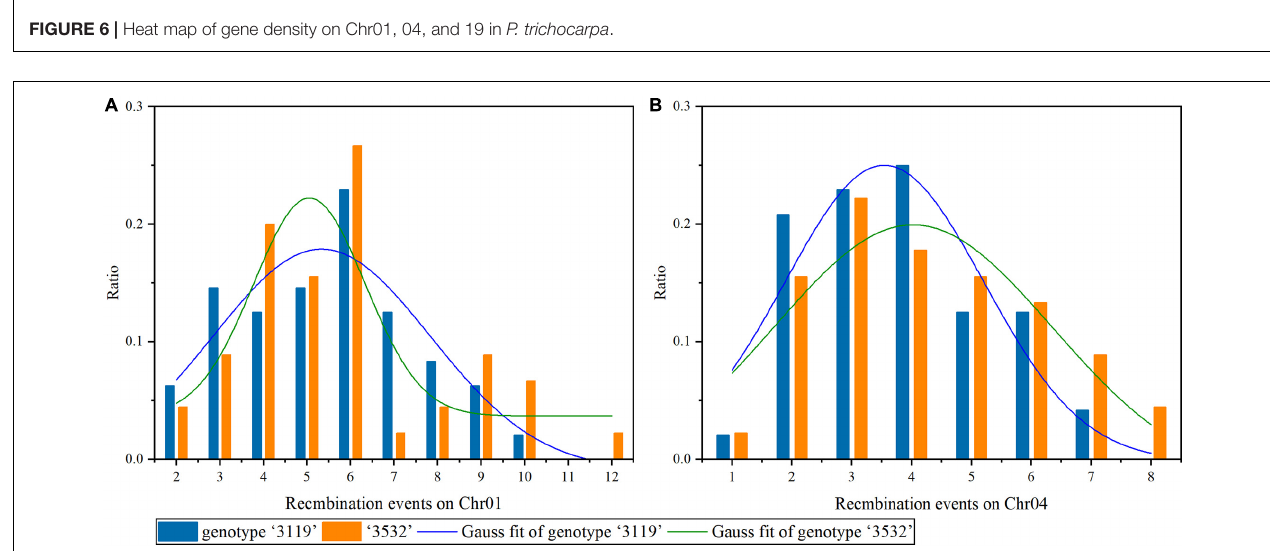
FIGURE 7 | Recombination events on chromosomes 1 and 4 under multiple markers detected. (A) Chr01, (B)